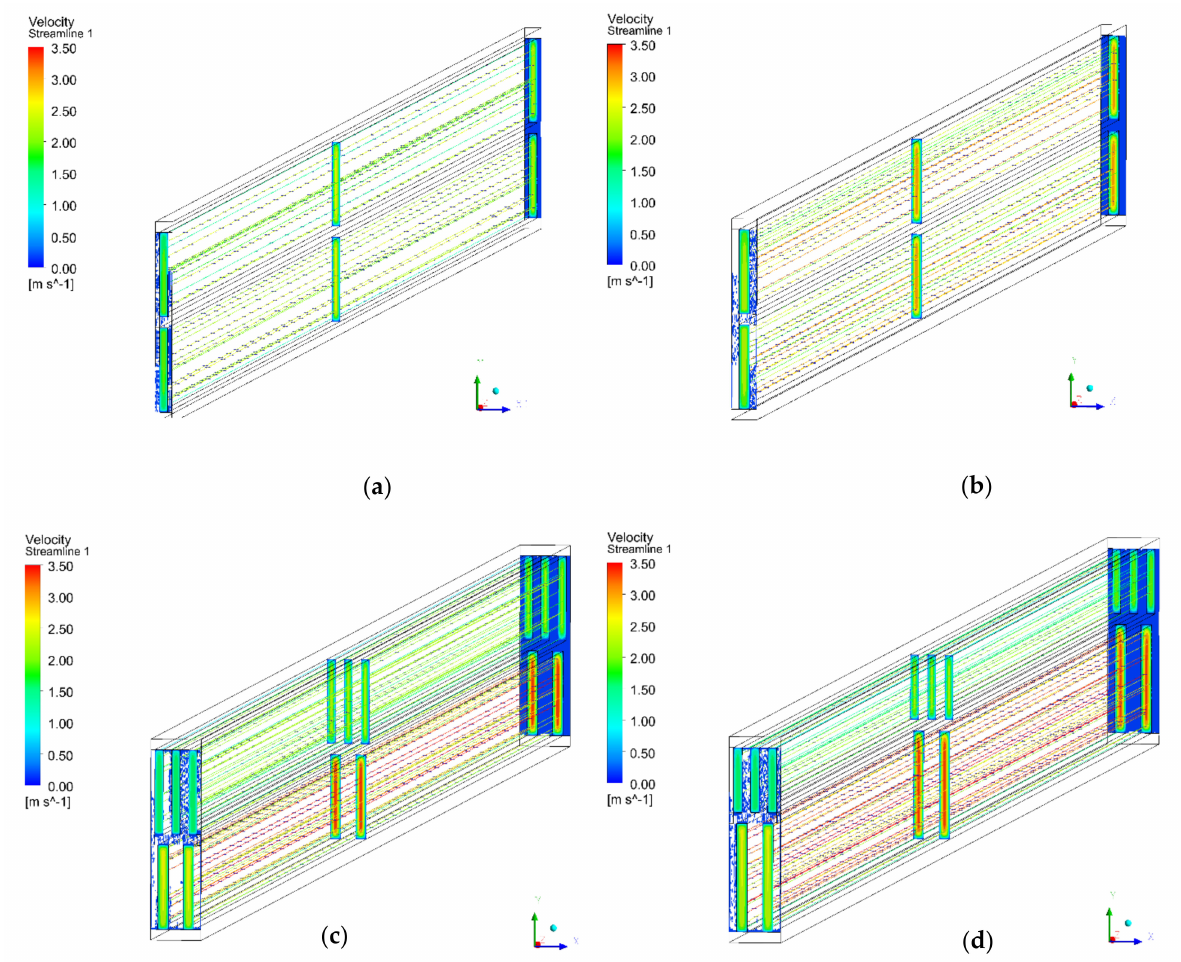
Figure 8. Velocity distribution of coolant ( u in = 0.75 m/s) for ( a ) case0, ( b ) case1, ( c ) case2, and ( d )